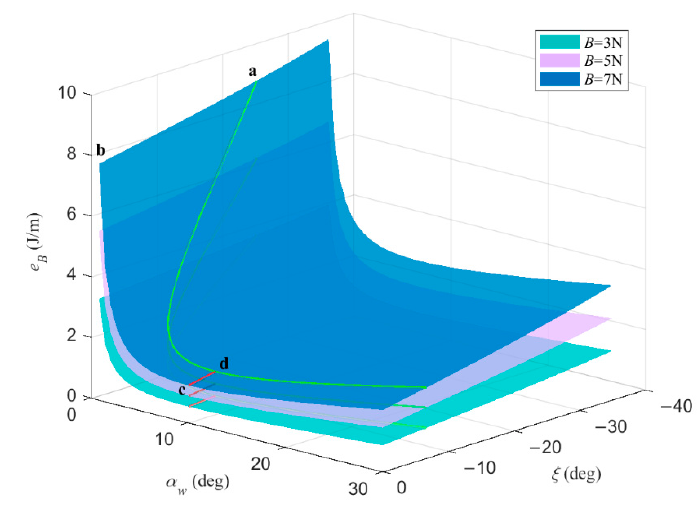
Figure 9. The e B − ξ − α w relationship under given net e ξ α− − Figure 9. The B w relationship under given net buoyancy.